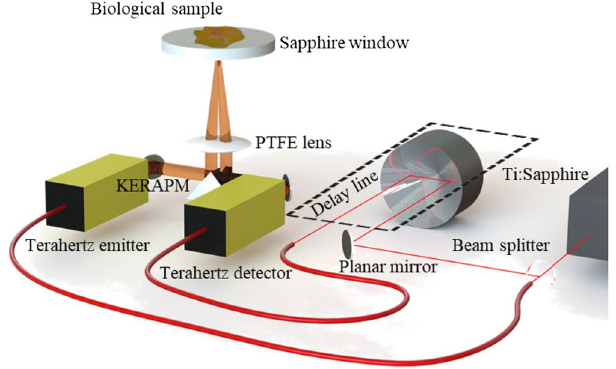
Figure 1. Schematic of the acquisition system. Drawn on SolidWorks 2020 SP3, www. solid works.